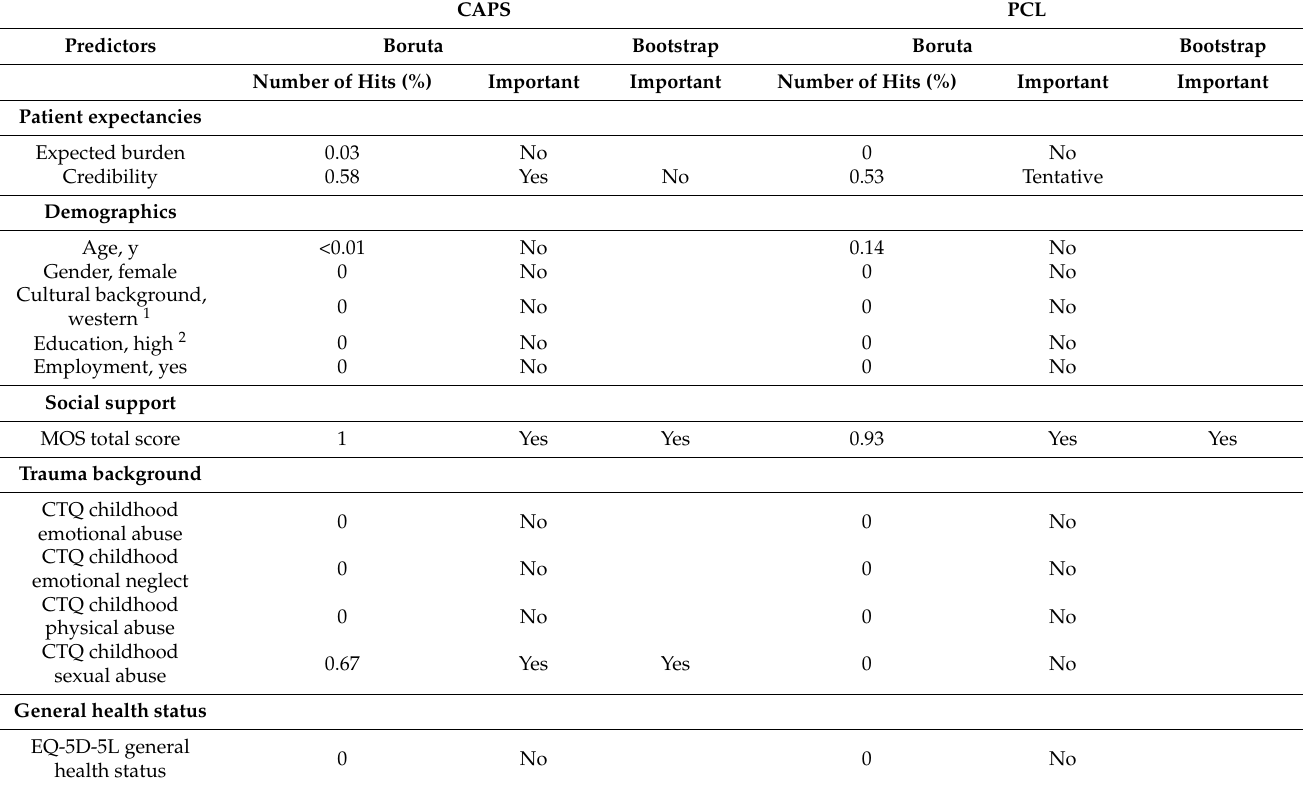
Table A1. Results from Boruta and subsequent bootstrap procedure for potential predictors of exposure therapies. CAPS PCL Predictors